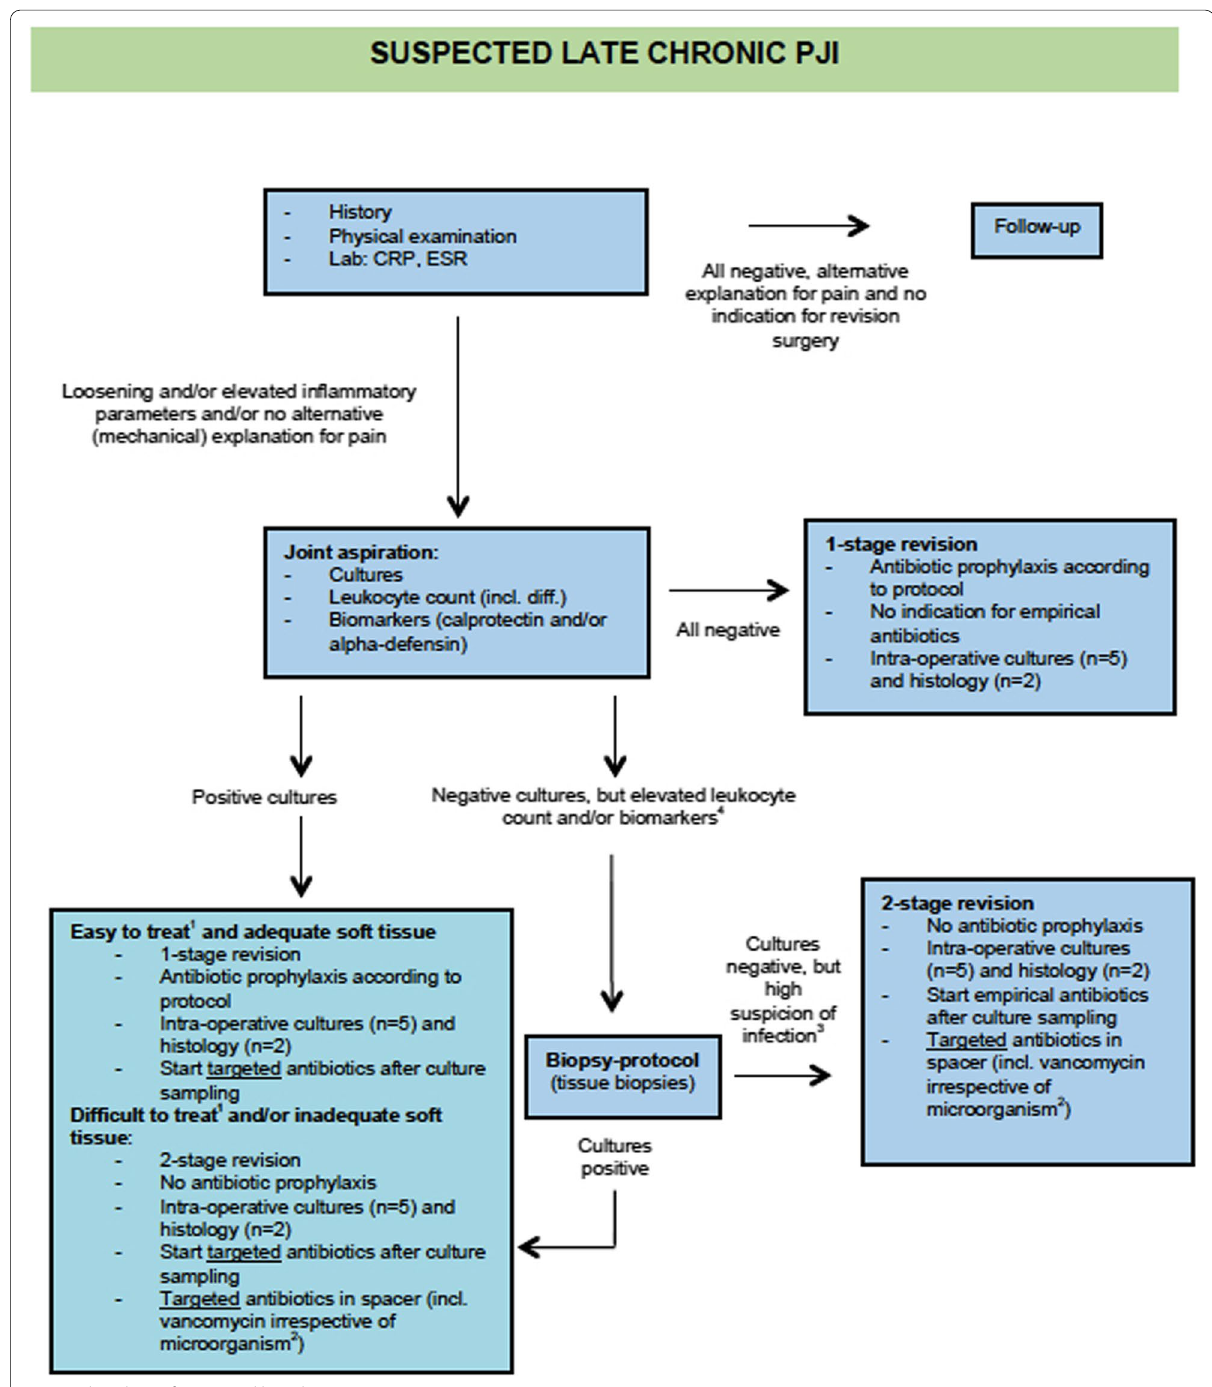
Fig. 2 Flowchart of suspected late chronic